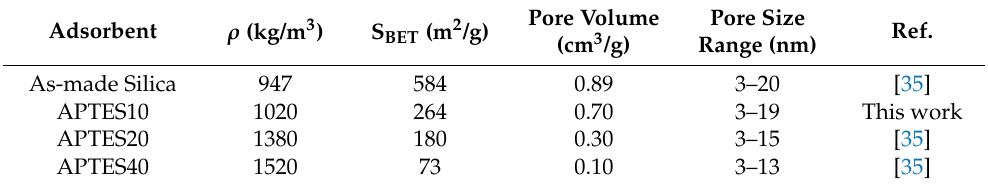
Table 1. Particle density, Brunauer–Emmett–Teller (BET) specific surface, and Barrett–Joyner–Halenda (BJH) pore volume of the adsorbent particles.